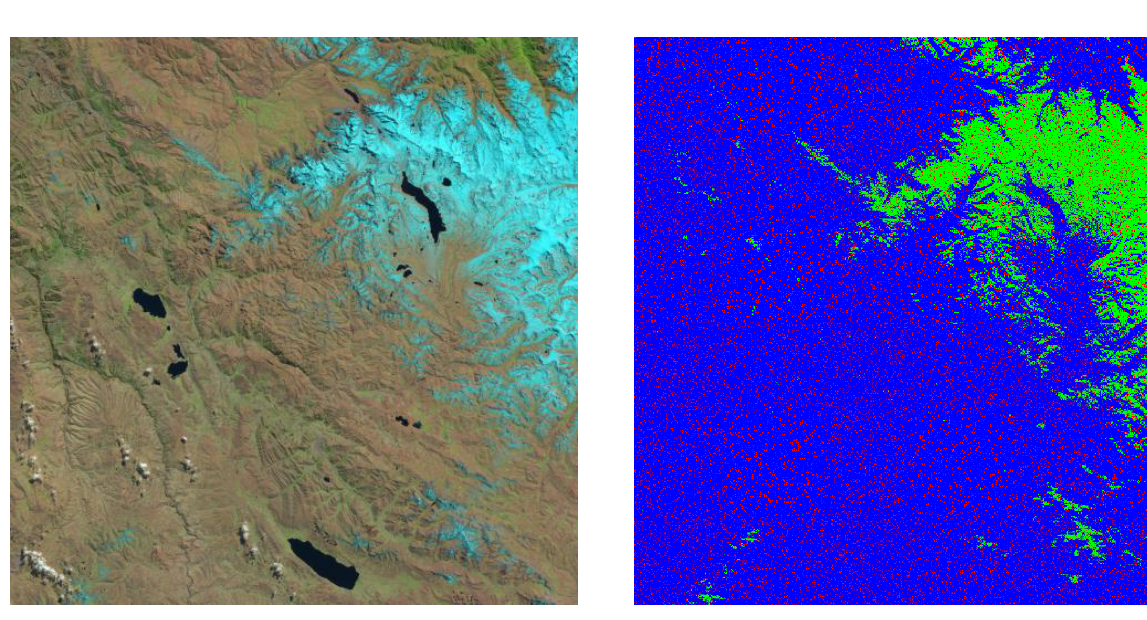
Figure 3. In blue and green, generalization samples; in red, training samples; both datasets randomly selected from ground truth data, for glacier and non-glacier areas, respectively.